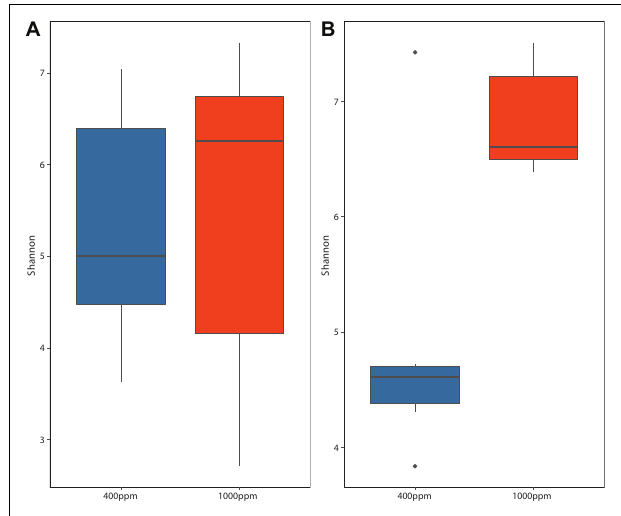
FIGURE 3 | Shannon diversity boxplot of the endolithic bacterial communities in the (A) Isopora palifera and (B) Porites lobata colonies under two p CO 2 treatments. Blue indicates the control (400 ppm p CO 2 ) and orange indicates the acidification treatment (1,000 ppm p CO 2